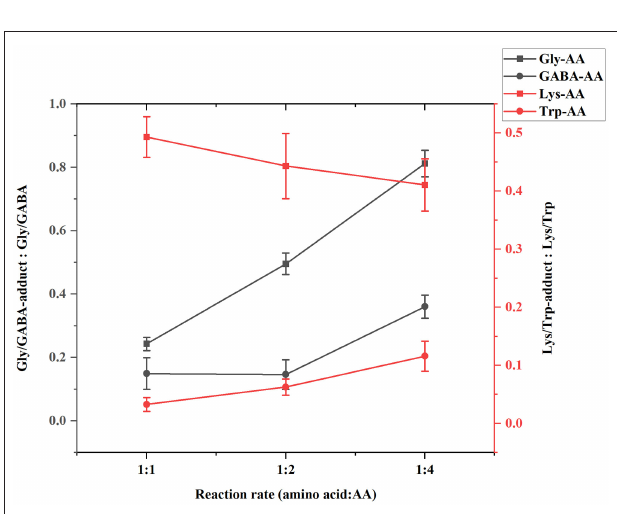
FIGURE 3 | Target adduct to amino acid ratio under different amino acid and AA reaction ratios.